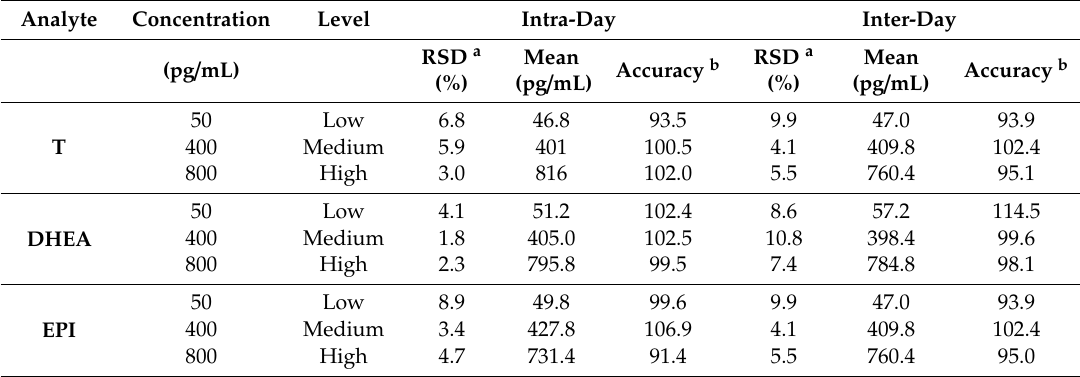
Table 6. Intra-and Inter-Assay Precision and Accuracy Results of Androgen Determination in Saliva Using LC-MS / MS ( n =